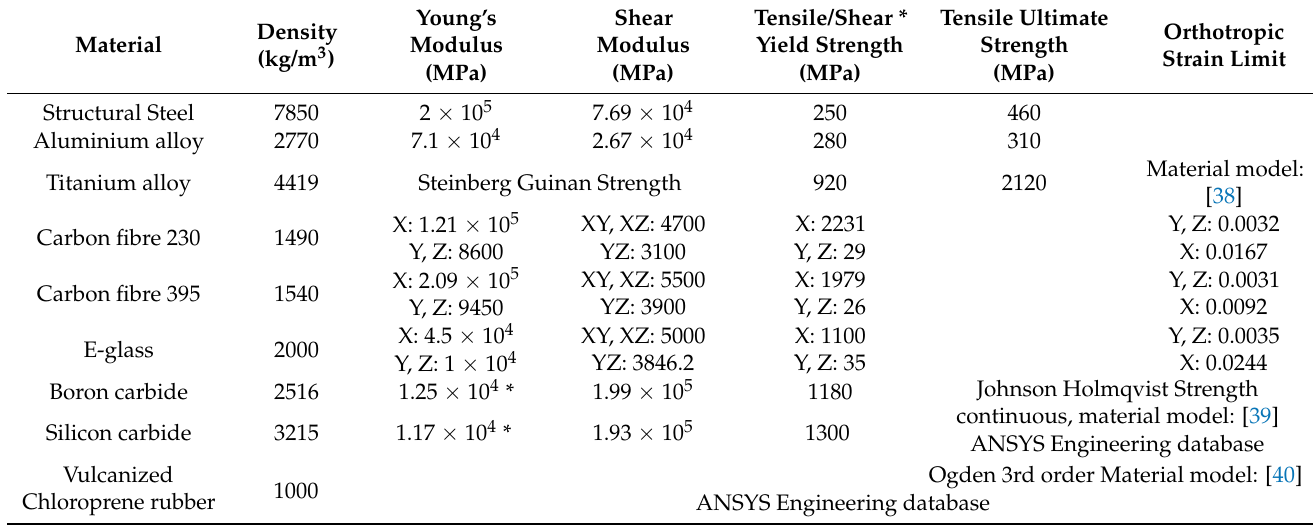
Table 2. Properties of materials used in the parametrisation of structural candidates (unless stated